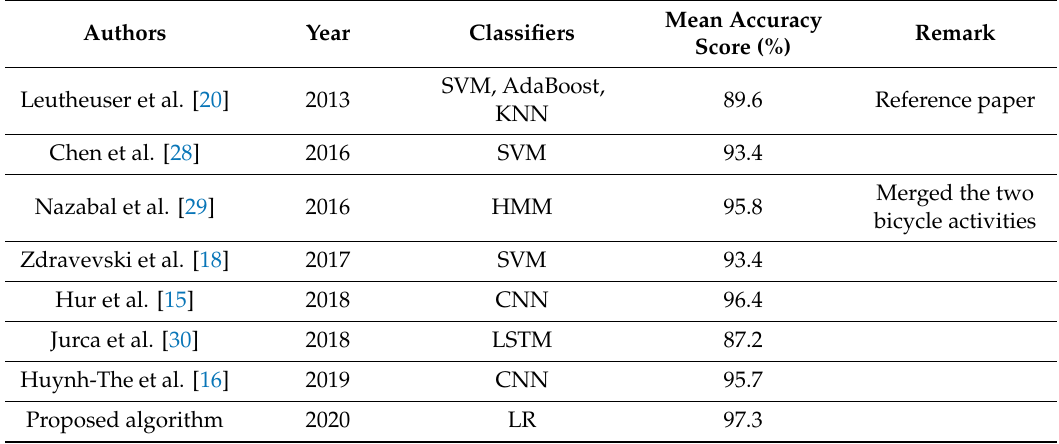
Table 1. Overview of previous algorithms applied to the DaLiAc dataset (with testing on unseen